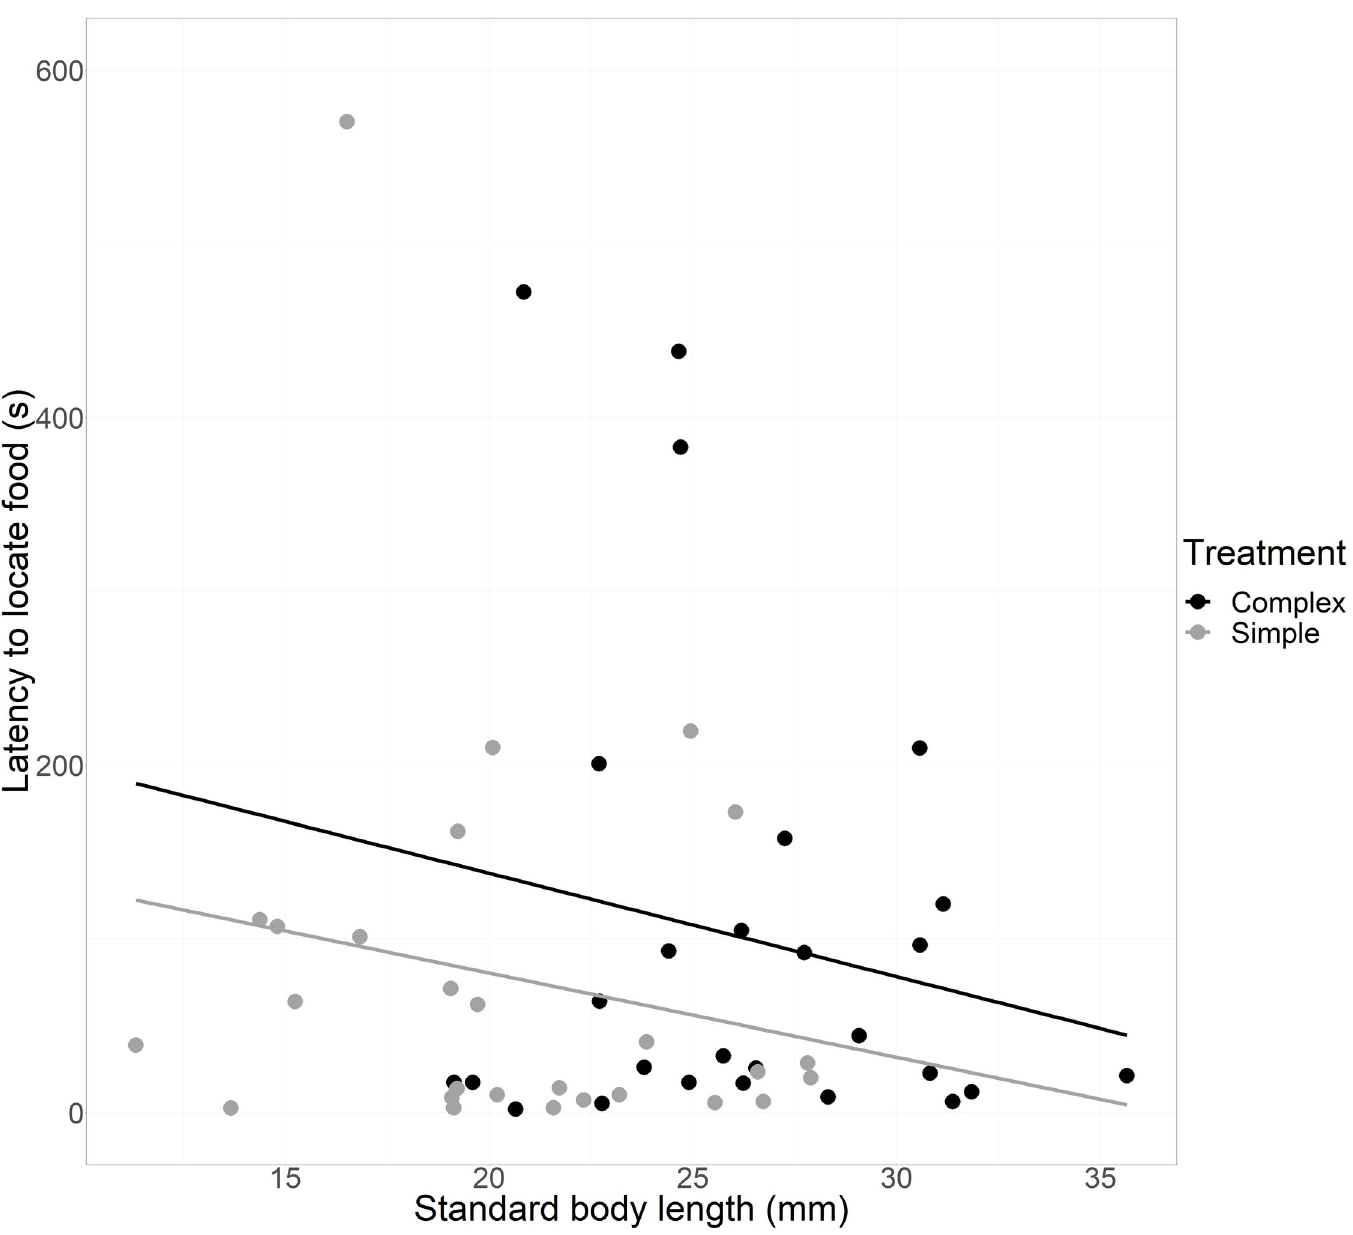
Fig 3. Effect of treatment on latency to locate food. Tendency lines are for visualisation of tendencies and derive from linear models for complex habitat (y = -124.23 + 10.38 x, r ^ 2 = -0.004) and simple habitat (y = -93.118 + 7.73 x, r ^ 2 = -0.003).